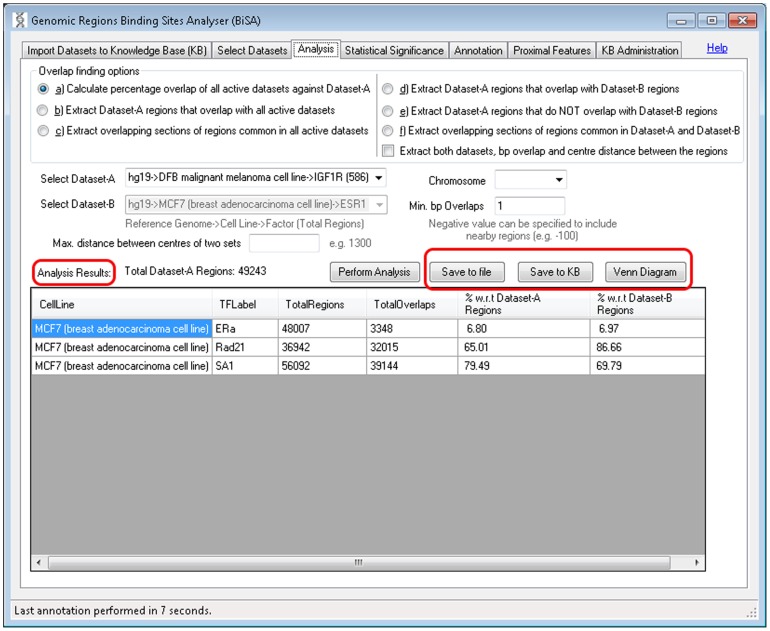
Analysis is the main overlap analysis tab of BiSA.BiSA offers six types of analysis: Overlap finding option a) reports overlap percentage with respect to the total Dataset-A regions and percentage with respect to the other active dataset regions. Overlapping or non-overlapping regions of Dataset-A can be extracted by options b), d) or e). Whereas, option c) or f) can be used to extract overlapping sections of regions common in all or two datasets. The results of overlap analysis type b), c), d), e) and f) can be saved back into the Knowledge Base by the ‘Save to KB’ button, allowing them to go into downstream analysis and independent annotation. Ticking the “Extract both datasets, bp overlap and centre distance between the regions” for options d), e) and f) displays both Dataset-A and Dataset-B regions, bp overlap and distance between the two sets.